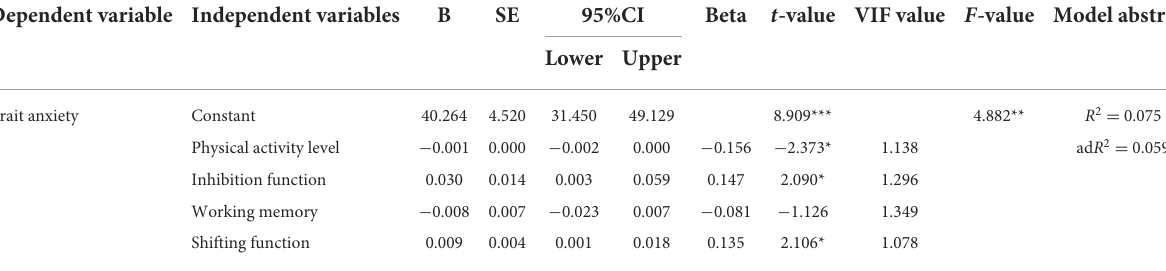
TABLE 2 Multiple linear regression analysis of influencing factors of trait anxiety among college